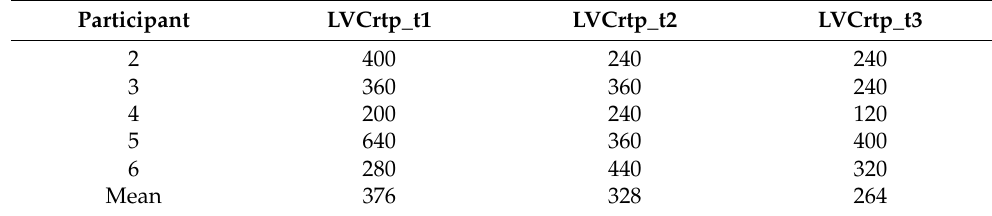
Table 21. LVCrt, pudding 10 mL (ms) individual and mean measurements at three assessment time points.